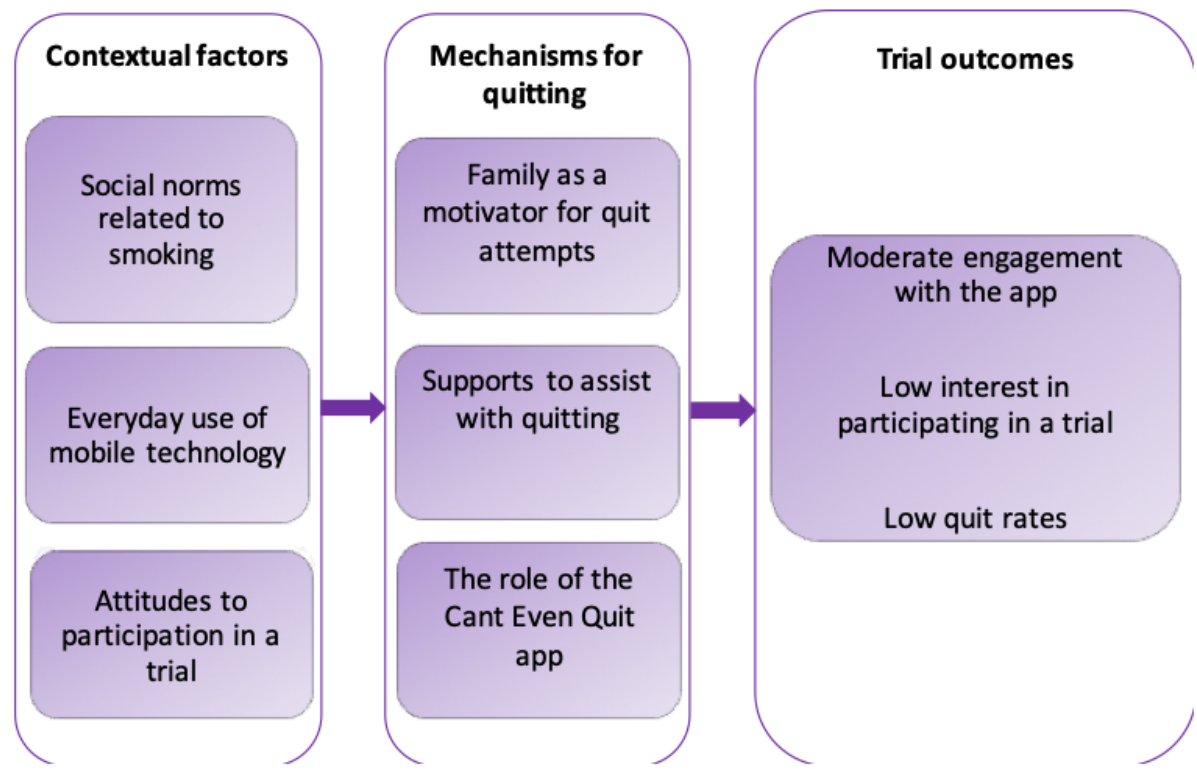
Figure 8. Qualitative themes and their influence on the trial